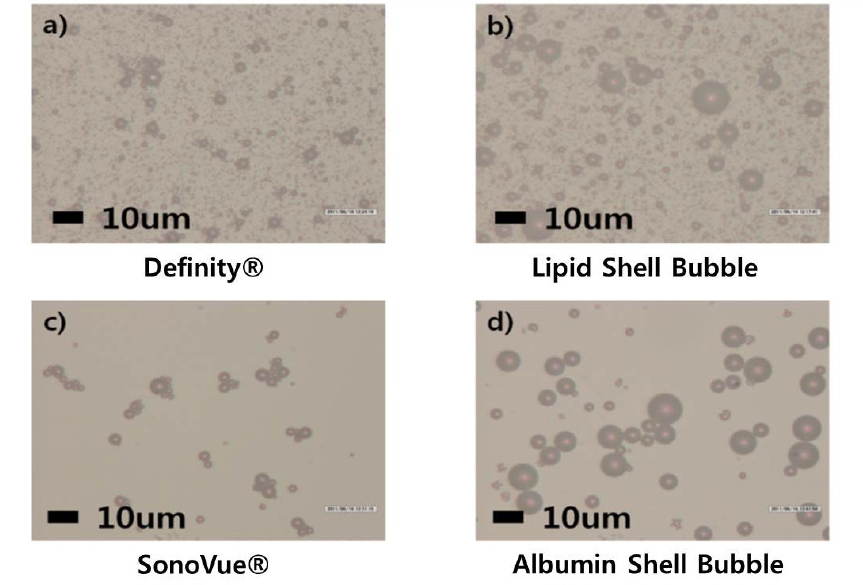
Figure 2. Optical images of the UCAs. The shape of the UCAs was observed under optical microscope at 1400× magnification.